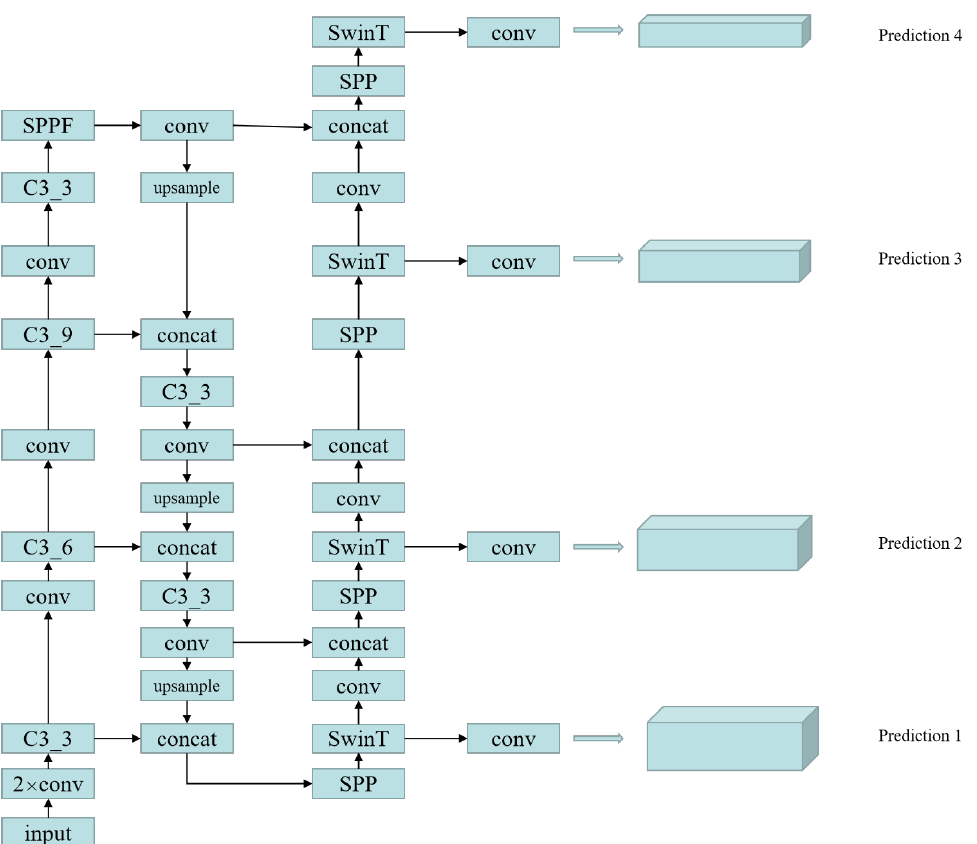
Figure 3. Detailed network structure diagram of Multi-Head-Attention-Yolo. We add a detection header on the low-level feature map and use the attention mechanism on detection header. Where C3_X represents 3 convs and X bottleneck and SwinT represents swin